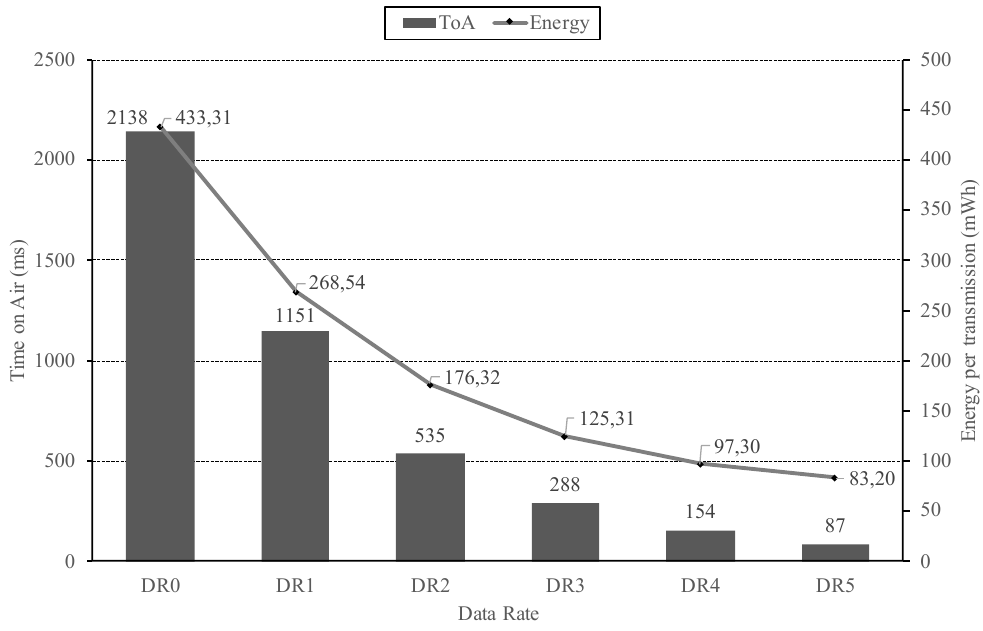
Figure 6. Time on Air and Energy per transmission for each data-rate (DR).